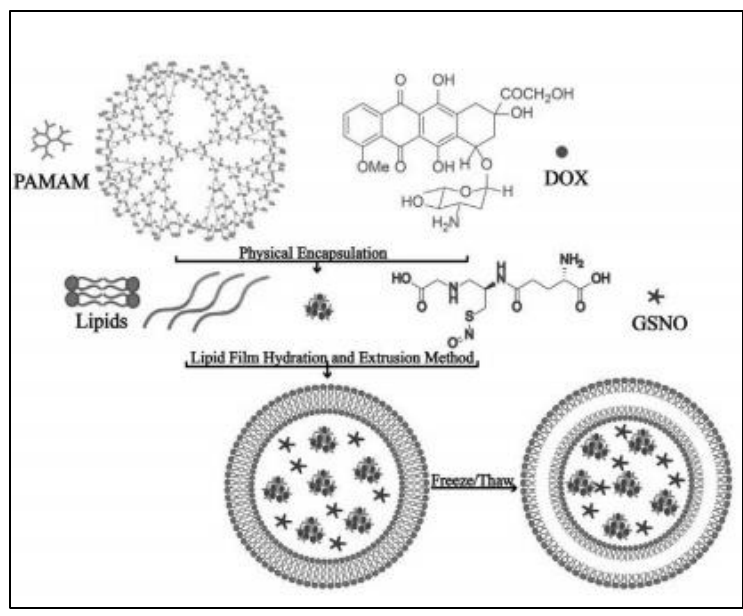
Figure 2. Scheme of ultrasound responsive liposome synthesis process [20].